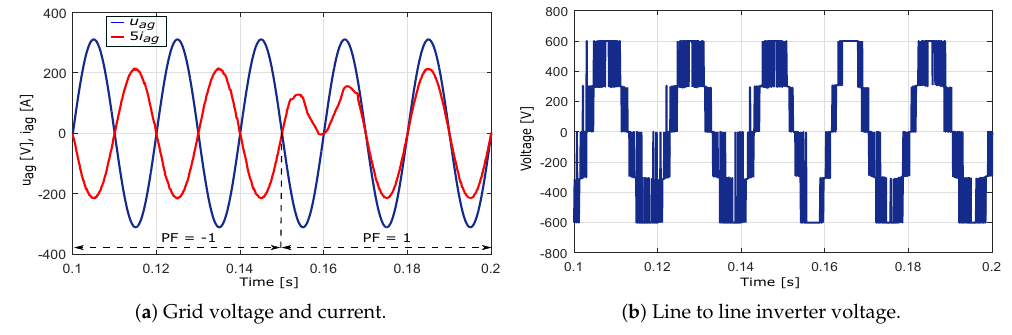
Figure 7. Inverter output voltage and grid voltage and current